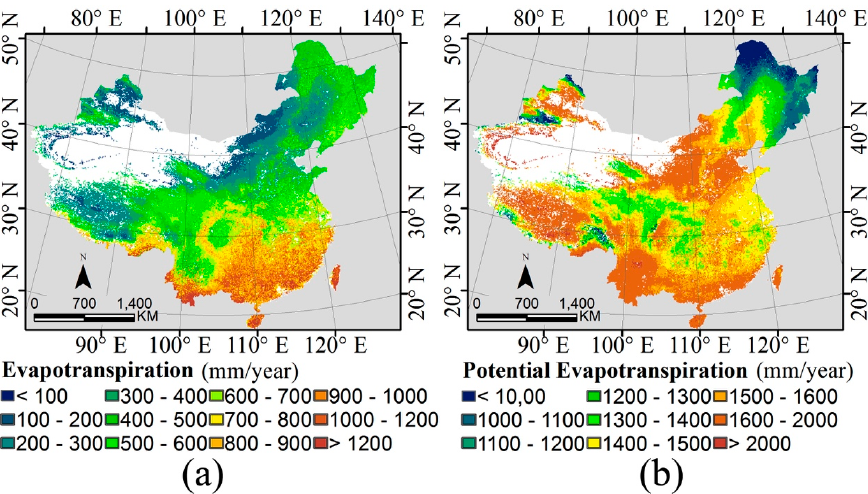
Figure 2. Geographical distributions of the long-term mean for ( a ) Evapotranspiration (ET); and ( b ) potential evapotranspiration (PET) (based on annual datasets from 2000 to 2013). Datasets were downloaded from the MOD16 website: http://www.ntsg.umt.edu.